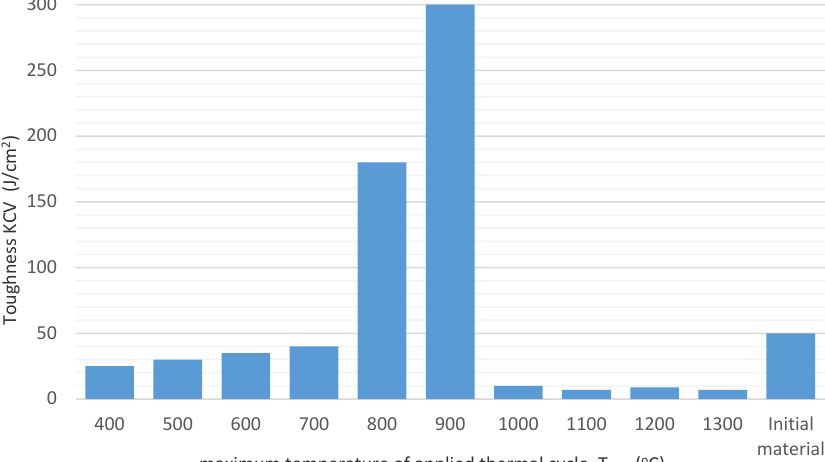
Figure 21. Toughness of steel S700MC thermo-mechanically simulated HAZ area at –30 °C in dependence of maximum temperature of applied thermal cycle.